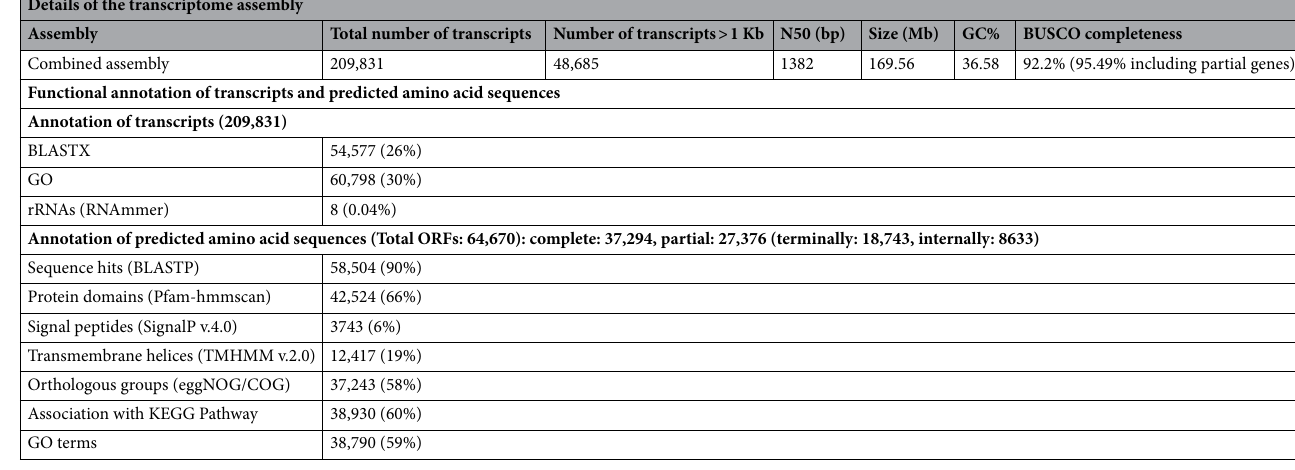
Table 1. Transcriptome assembly and annotation